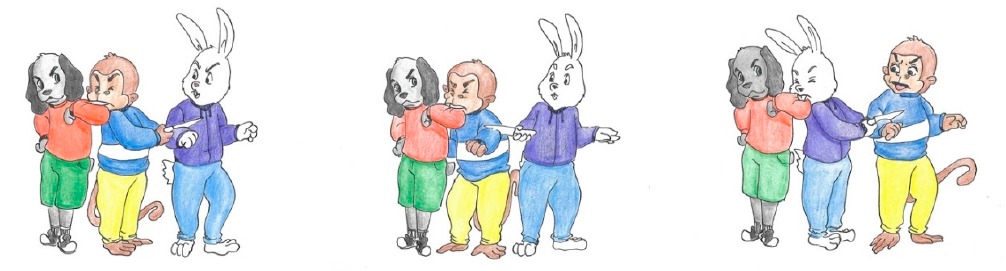
Figure A25. ORC stimulus 10.